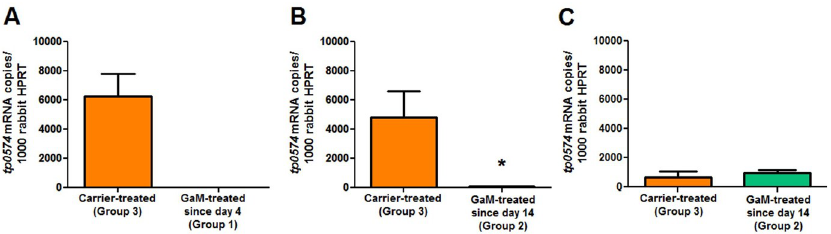
Fig 4. Quantification of treponemal tp0574 mRNA in lesion biopsies. Treponemal burden in lesion biopsies harvested at day 13 post-inoculation from Group 1 and Group 3 animals (A), day 23 post-inoculation in Groups 2 and 3 rabbits (B), and at day 33 post-inoculation in Groups 2 and 3 rabbits (C). tp0574 copy number is normalized to 100 copies of rabbit HPRT message. Asterisk indicates statistical significance (p < 0.05).